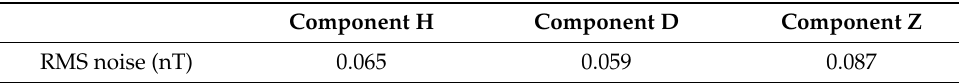
Figure 11. Three-component data waveform from the prototype fluxgate sensor in the shielding cylinder. Table 3. Noise test results. Table 3. Noise test results.